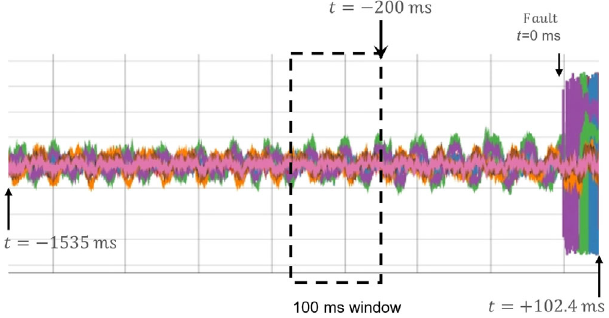
11. Recorded waveforms and window taking of the CEBAF SRF fault forecasting model (from [71], Fig.